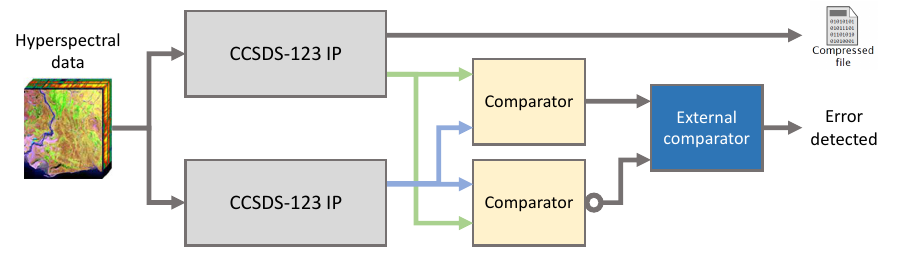
Figure 7. Dual Modular Redundancy (DMR) protection